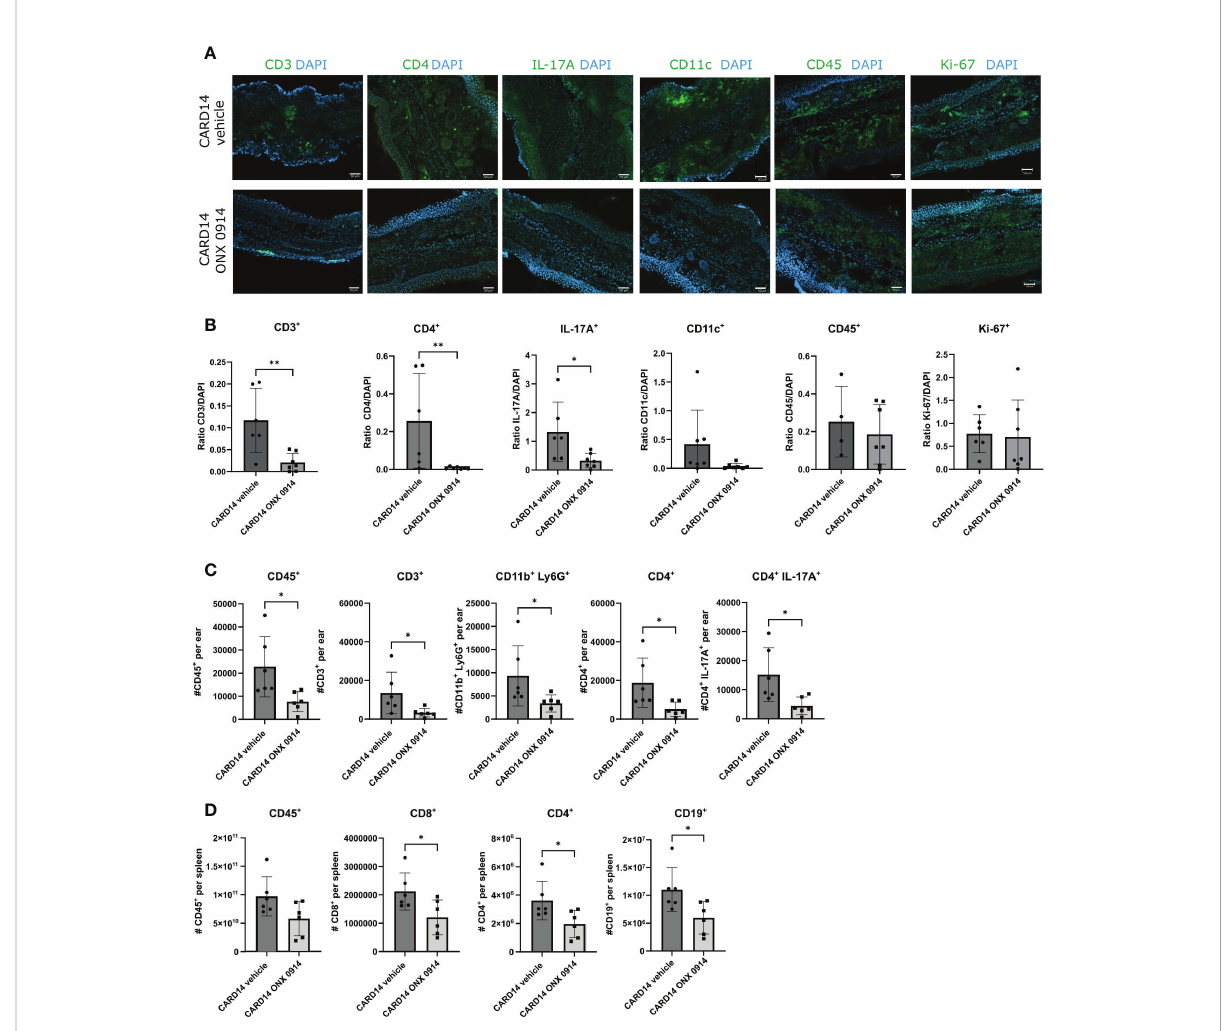
FIGURE 3 Immune cell populations in the ear and spleen of Card14 D E138 +/- mice: 8-10 week old Card14 D E138 +/- mice were treated on alternate days with 10 mg/kg ONX 0914 (n=6-7) or vehicle (n=4-7). 20 days after treatment, 14 m m ear cryosections were stained with anti-CD3, anti-CD4, anti-IL-17A, anti-CD11c, anti-CD45, anti-Ki67, antibodies (all in green) and DAPI (in blue). Representative images are shown. The scale bar is 50 m m (A) . The positive signals were quanti fi ed with ImageJ (B) On the g -axis, the ratio of the fl uorescence signal to DAPI is depicted. Data (n=4-7) were pooled from 2 independent experiments and statistically analyzed by unpaired t-test or Mann-Whitney test. (C) A single cell suspension of the ear (n=6) was prepared after 20 days of ONX 0914 or vehicle treatment and the CD45 + , CD3 + , CD11b + Ly6G + , CD4 + , and CD4 + IL-17A + populations were analyzed. On the g -axis, the absolute cell count per ear is depicted. (D) The spleen was analyzed for CD45 + , CD8 + , CD4 + , and CD19 + . The absolute cell number is depicted on the g -axis. Data were pooled from 2 independent experiments (n=6) and statistically analyzed by unpaired t-test or Mann-Whitney test. (C, D) The cells were gated on CD45 + cells after doublet and dead cell exclusion. The gating strategy for C and D is depicted in Supplementary Figure 3B Representative fl ow cytometry plots for C and D are depicted in Supplementary Figure 4A. All values represent mean ± SD. * p < 0.05, and ** p